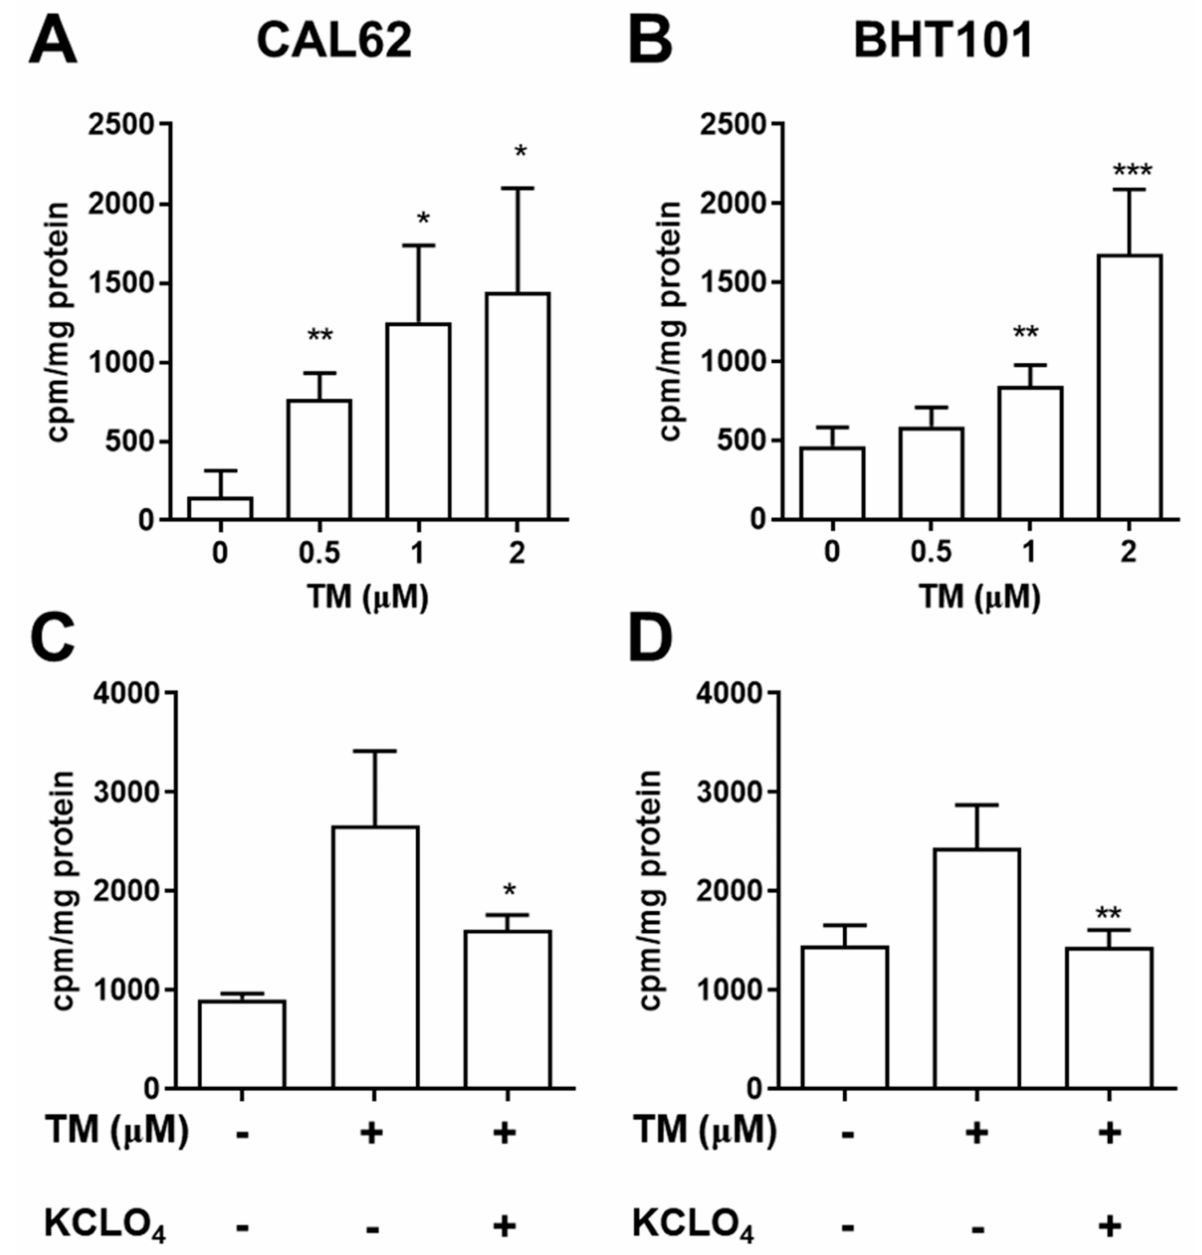
Figure 1. Effect of tunicamycin (TM) on iodide uptake in ATC cells. ( A , C ) CAL62 and ( B , D ) BHT101 cells were treated with various TM doses for 24 h, followed by iodide uptake assays. To examine the inhibition of iodide uptake, ATC cells were treated with 2 µ M TM and 300 µ M KClO 4 (sodium-iodide symporter (NIS)-specific inhibitor) for 24 h, and iodide uptake was assessed. * p < 0.05, ** p < 0.005, *** p < 0.0005, compared to absence of TM (Iodide uptake assay). * p < 0.05, ** p < 0.005 compared with TM (KCLO 4 inhibition study). Data are the mean ± SD of three samples per